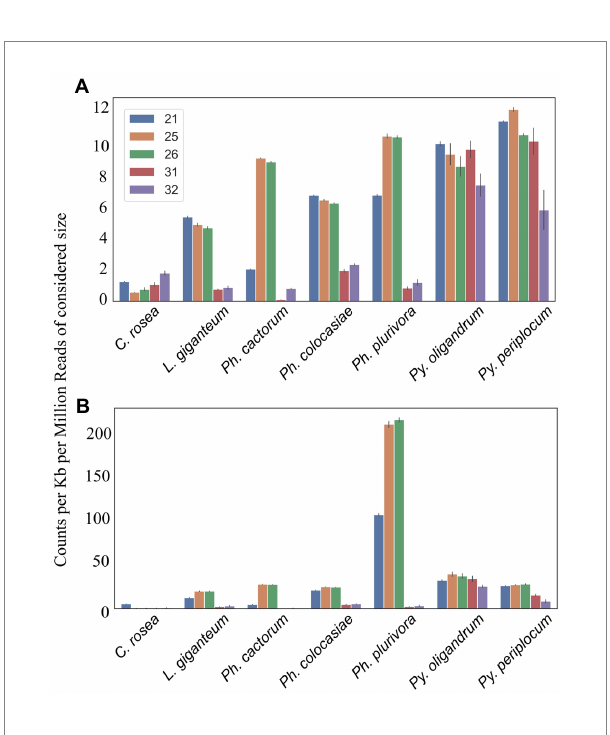
FIGURE 5 Number of reads mapping to transcripts. Data normalized according to total kb extent of the transcriptome in the genome and to millions of reads of the specific sRNA size for the sample. Error bars indicate the standard deviation. (A) All transcripts. (B) Duplicated